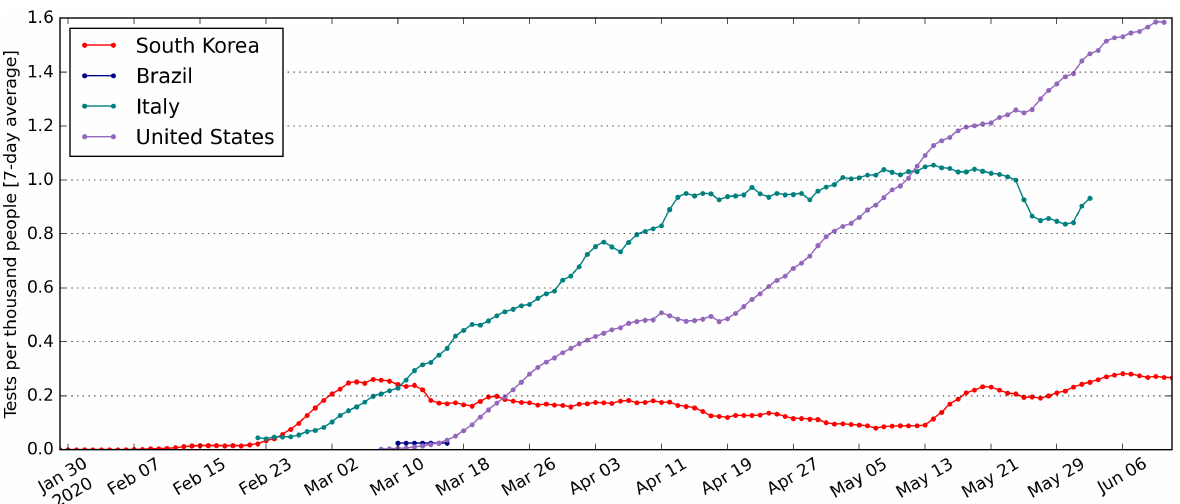
Figure 2. Brazil has a low level of daily COVID tests according to Coronavirus Pandemic (COVID-19) publication data (Ritchie et al.